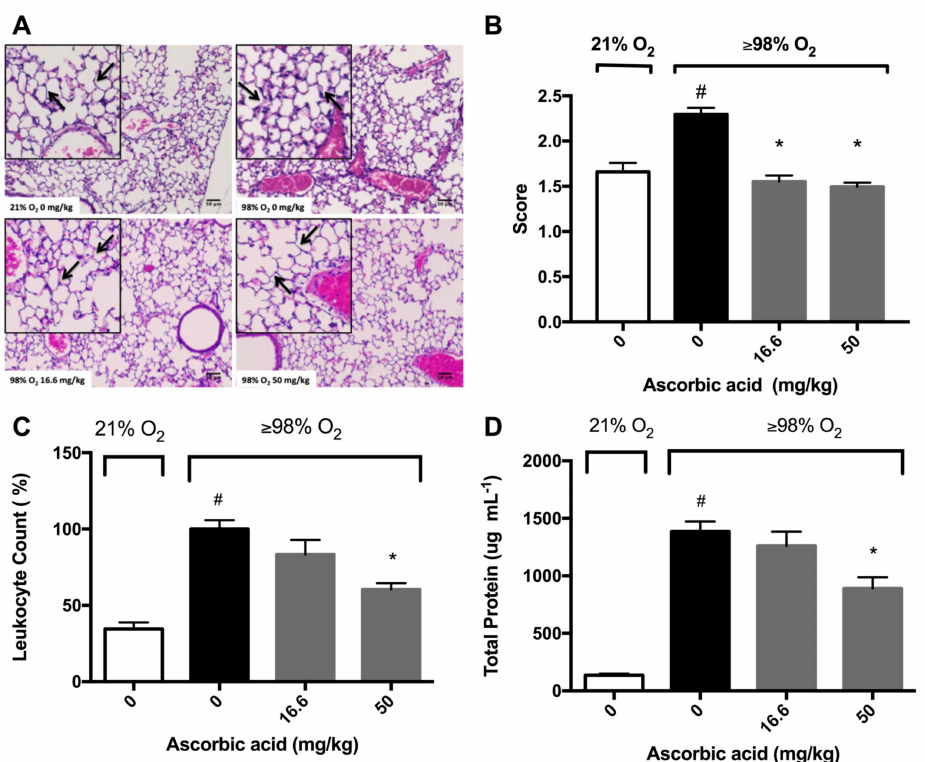
Figure 5. Ascorbic Acid (AA) attenuates hyperoxia-induced lung injury. Mice were exposed to ≥ 98% O 2 or 21% O 2 for 72 h and randomized to receive either AA (16.6 or 50 mg / kg i.p. ) or saline. Mice were sacrificed and the lungs were perfused with 10% formaldehyde and harvested from the mice. Histological micrographs (originally taken at 200x magnification) with hematoxylin and eosin staining ( A ) show leukocytes (blue dots) and alveolar septa thickening (arrows) ( n = 2–4 each group), and lungs were scored to assess inflammatory injury ( B ). In a di ff erent set of experiments, BALF was harvested and leukocyte infiltration ( C ) and protein content ( D ) were determined. The pictures are representative images from each group ( n = 4 each group). The data represent the mean ± SEM of three independent experiments. * p ≤ 0.05 compared to ≥ 98% O 2 0 mg / kg control mice. # p ≤ 0.05 compared to 21% O 2 control